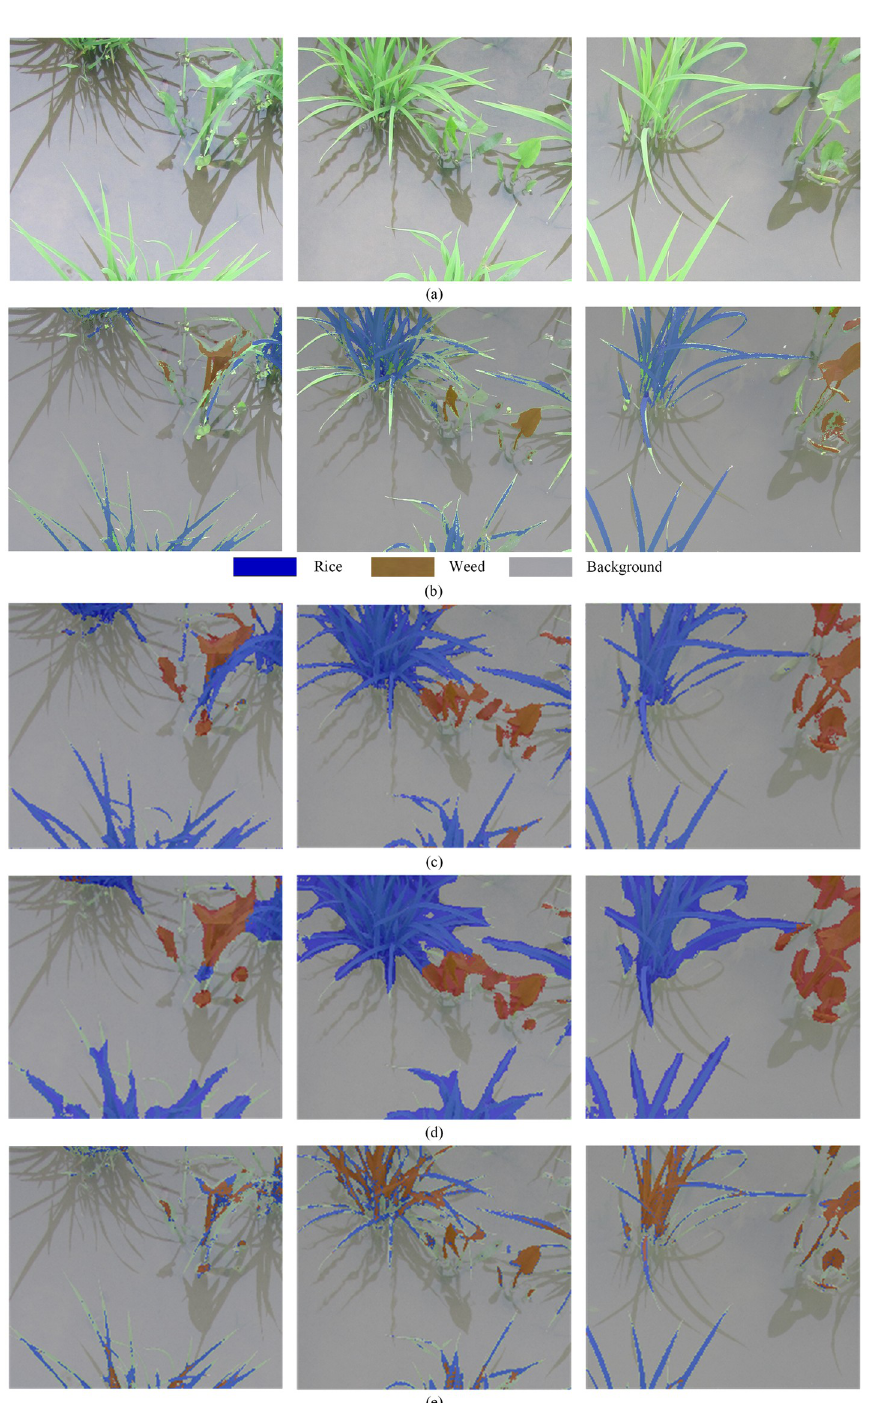
Fig 6. Performance comparison on test images. (a) original images; (b) ground truth; (c) output by our method; (d) output by FCN; and (e) output by U-Net.